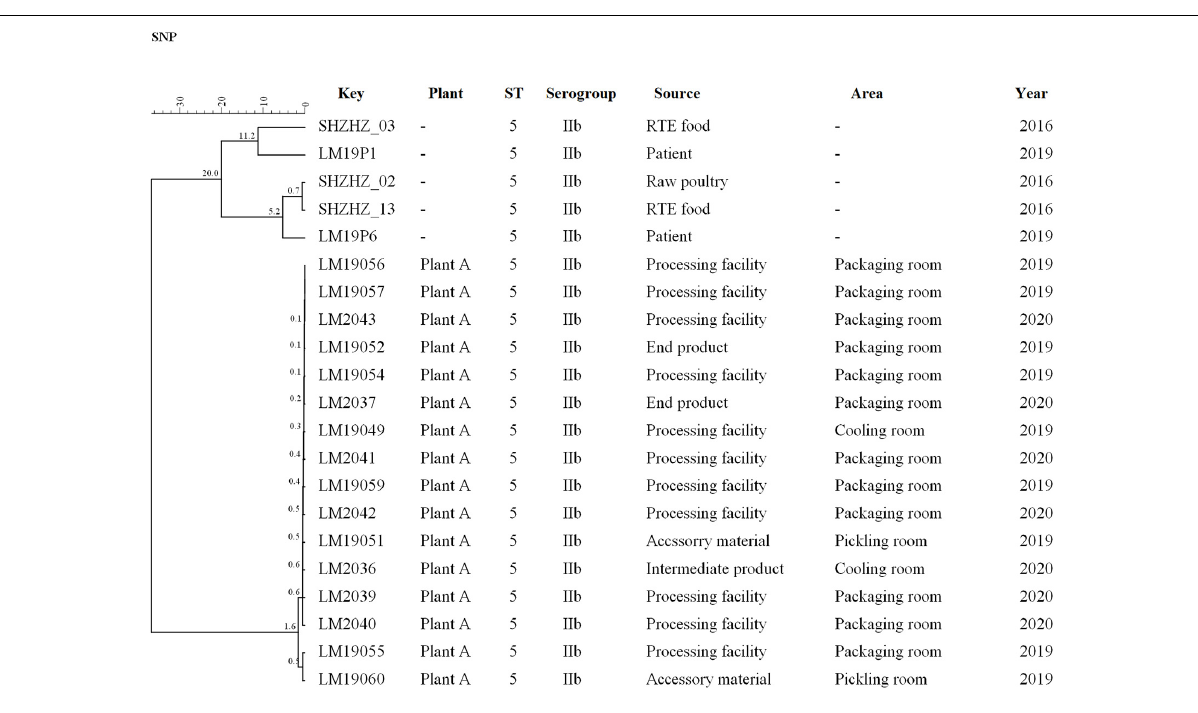
FIGURE 3 | Clustering of the 16 L. monocytogenes based on SNPs by BioNumerics software using five unrelated L. monocytogenes isolates for comparison. LM19057 isolated from plant A was used as reference. The corresponding data, including the name of these isolates (Key), source (Plant), ST, serogroup, and year, are shown along with the dendrogram to the